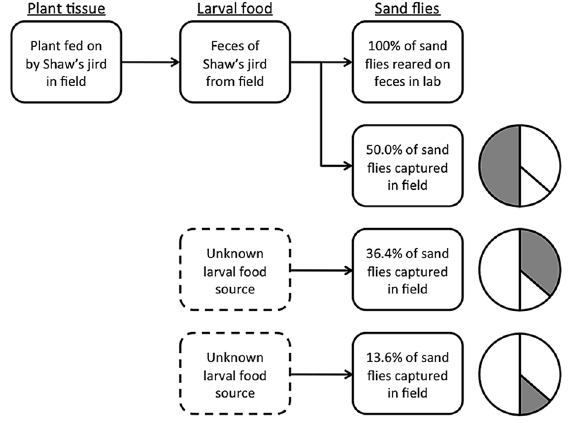
Figure 3. Diagram of the use of stable isotope analysis to link the plants used for forage by jirds to the feces produced by these jirds and to sand flies that had fed on these feces as larvae. The d 13 C and d 15 N values of 100.0% of sand flies fed jird feces as larvae in the lab and 50.0% of sand flies captured at the study site matched the field collected jird feces. Stable isotope analysis also indicated the remaining 50.0% of sand flies captured at the study site had fed as larvae on one of two distinct alternative (and currently unknown) food sources other than jird feces.